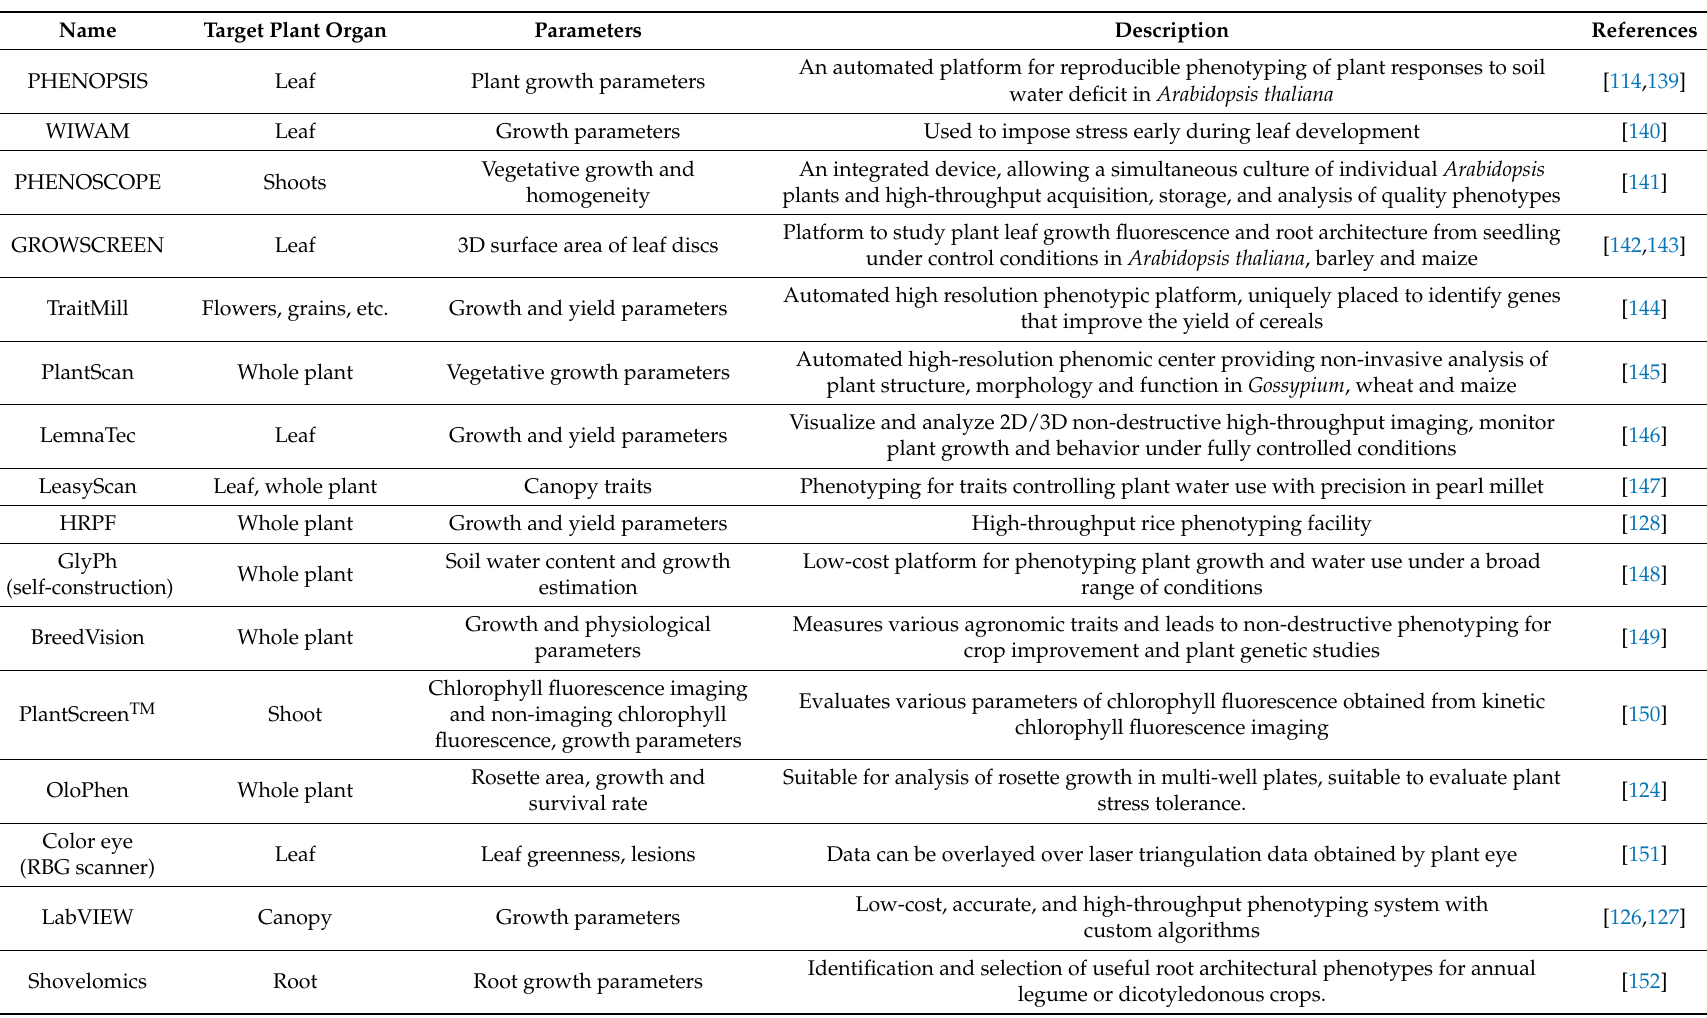
Table 1. Commonly used high throughput plant phenotyping platforms (HTPPs) across agricultural and model